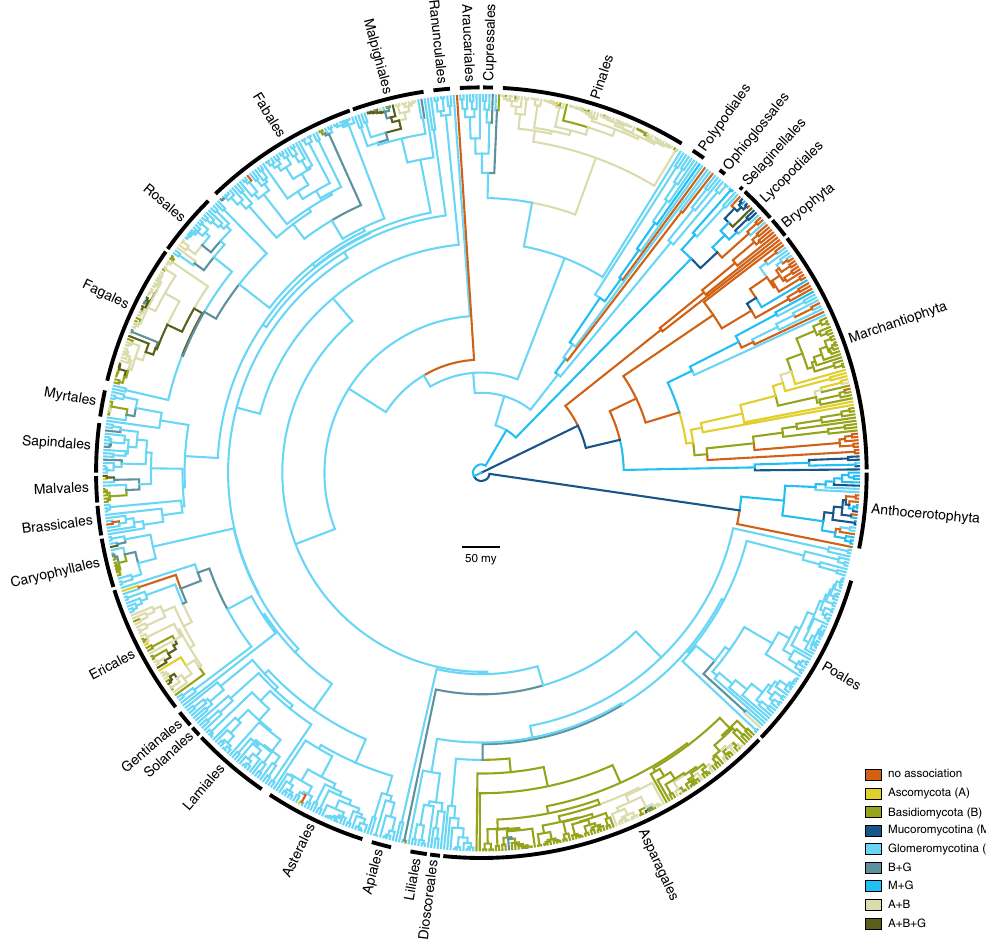
Figure 1. Evolution of mycorrhiza-like associations in land plants. Chronogram showing the ancestral state reconstructions of mycorrhiza-like associations in land plants ( n = 732 species) using a phylogenetic hypothesis in which a clade consisting of liverworts and mosses are the sister group of all other land plant species. Branches are coloured according to the most probable state of their ancestral nodes. Main plant lineages are marked with black labels. Branch lengths represent time in million years. Bar is 50 million years.